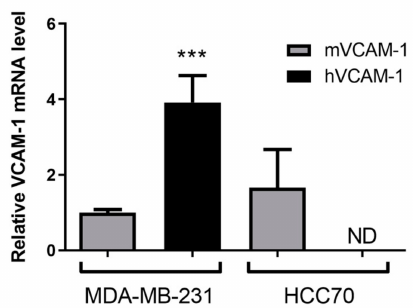
Figure 4. Ex vivo assessment of VCAM-1 expression by RT-qPCR. 50 mg of MDA-MB-231 and HCC70 xenografts were harvested and tested for human and mice VCAM-1 expression by RT-qPCR. *** p < 0.001 vs. MDA-MB-231